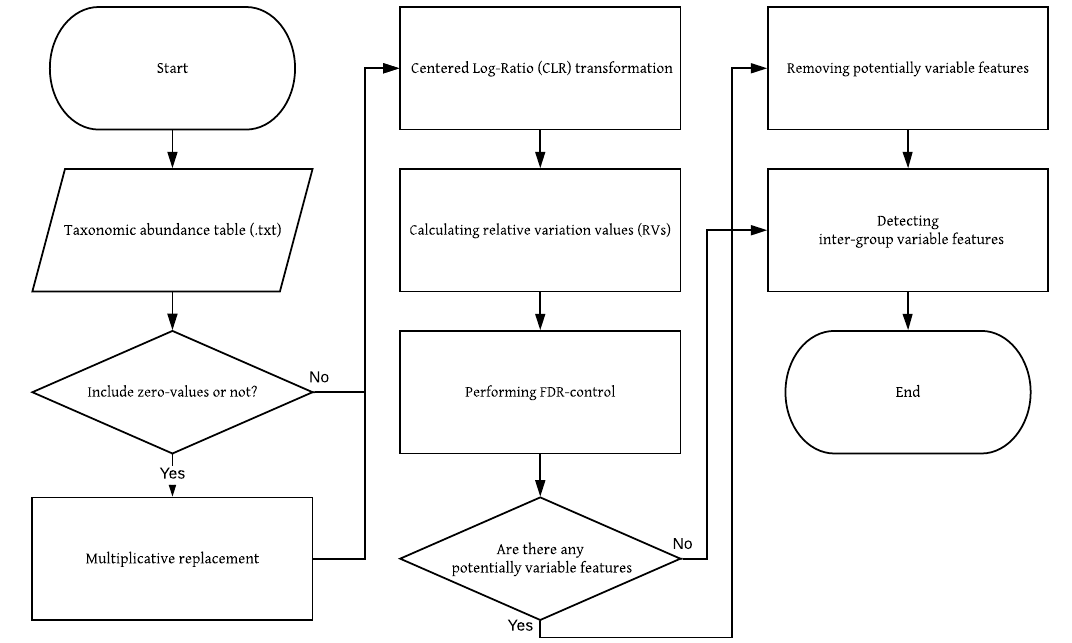
Figure 1. Flowchart of BRaVO. This flowchart shows the logic of the BRaVO algorithm. The parallelogram means the input data. The rectangular box means the process or data manipulation. A diamond shape indicates a decision process. The taxonomic abundance table indicates the taxonomic count data obtained from OTU tables. A zero-value means the absence of observation in the taxonomic abundance table. Potentially variable features indicate outliers independent of